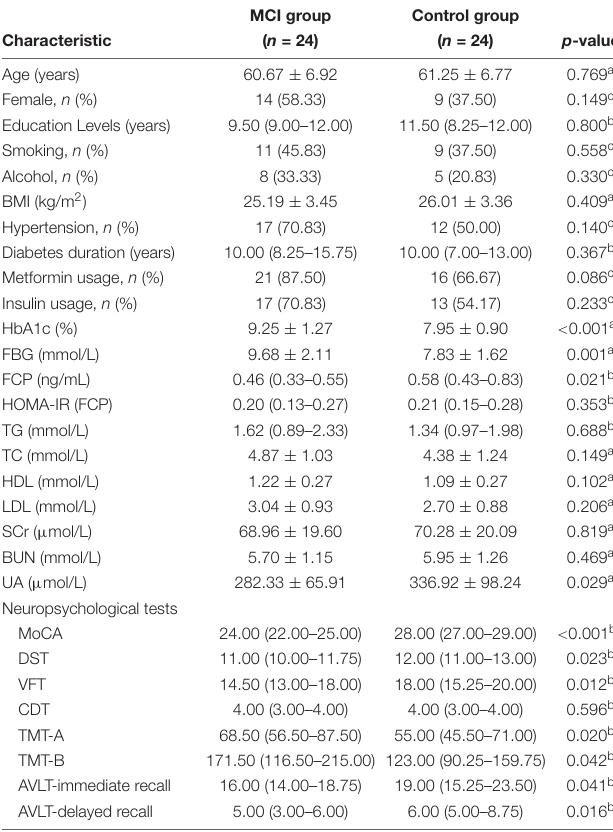
TABLE 1 | Sociodemographic, clinical characteristics and cognitive performances. MCI